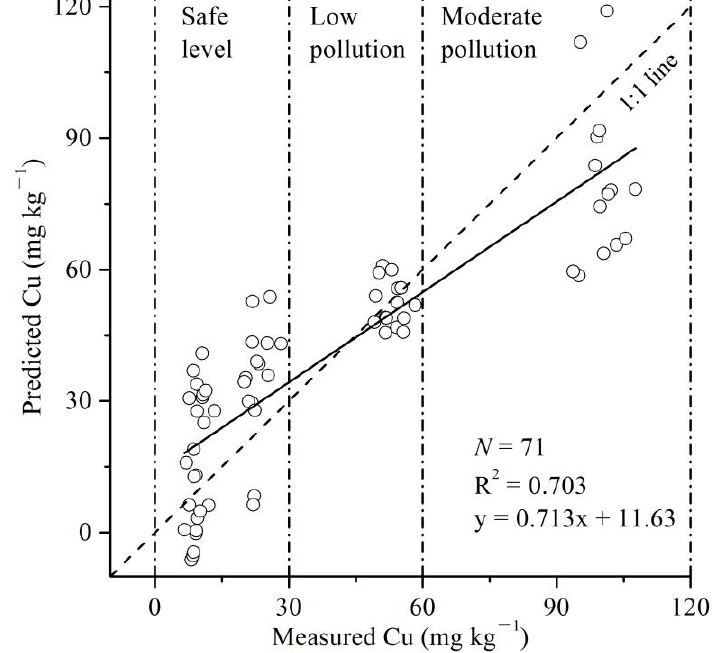
Figure 8. Scatterplot of the measured against predicted Cu concentration with the full dataset ( N = 71) based on the general model ( 𝑌 for Cu